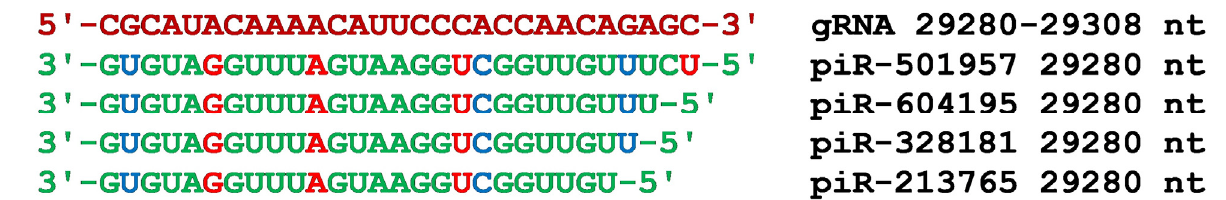
10 of 16 Figure 12. Nucleotide sequences of the 10 piRNA BSs cluster in the CDS of gRNA from 28,447 nt to 28,471 nt and the nucleotide sequences of piRNAs. Note: The piRNA nucleotides that form canonical pairs with gRNA are highlighted in green and non ‐ canonical pairs are highlighted in blue. The piRNA nucleotides that do not interact with gRNA are highlighted in red. The names of the piRNAs are followed by the beginning of their BSs. The last cluster of piRNA BSs was located in the region from 29,280 nt to 29,308 nt of gRNA, which also encodes the N protein (Figure 13). Before this BSs cluster at position